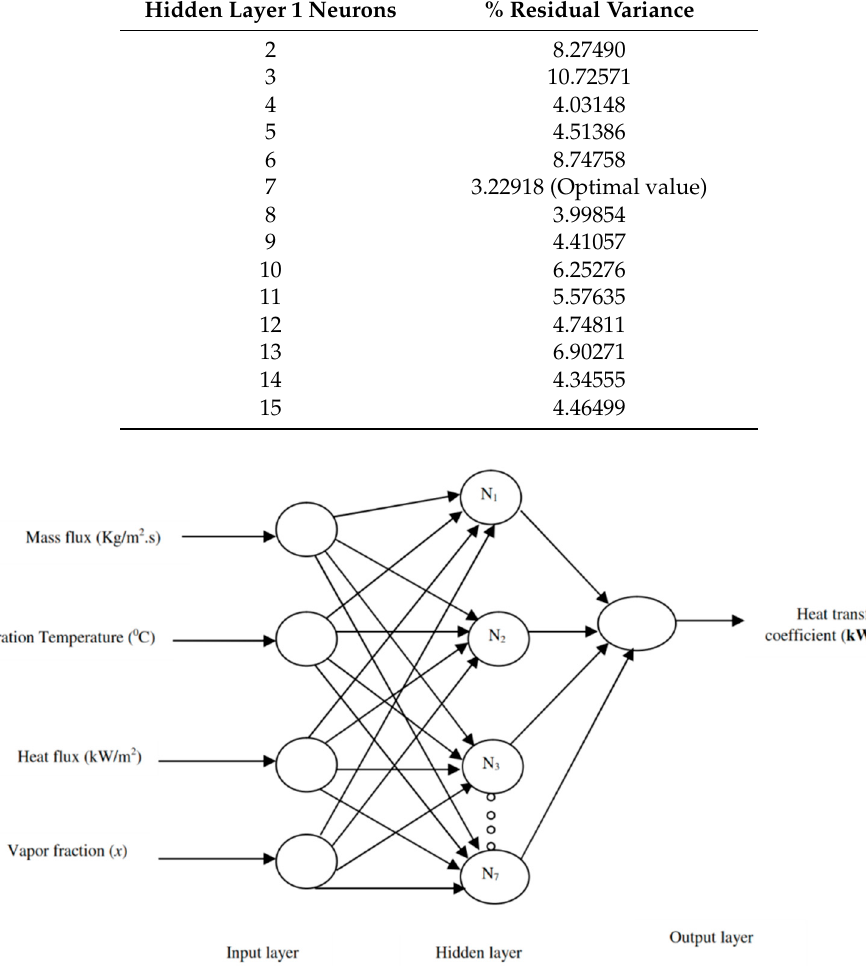
Figure 1. The schematic topology of the 4:7:1 ANN architecture.